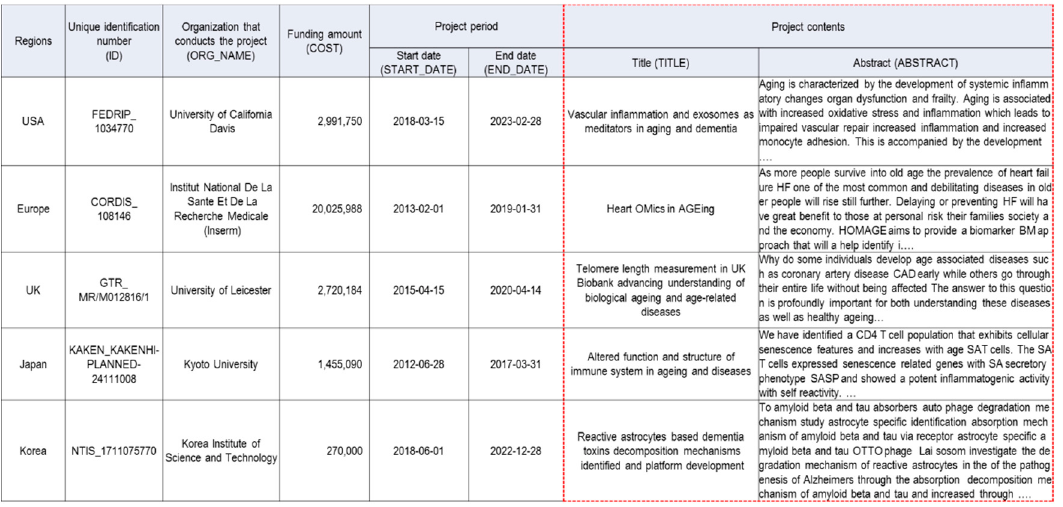
Figure 1. Examples of data on R&D public projects in the global R&D database.